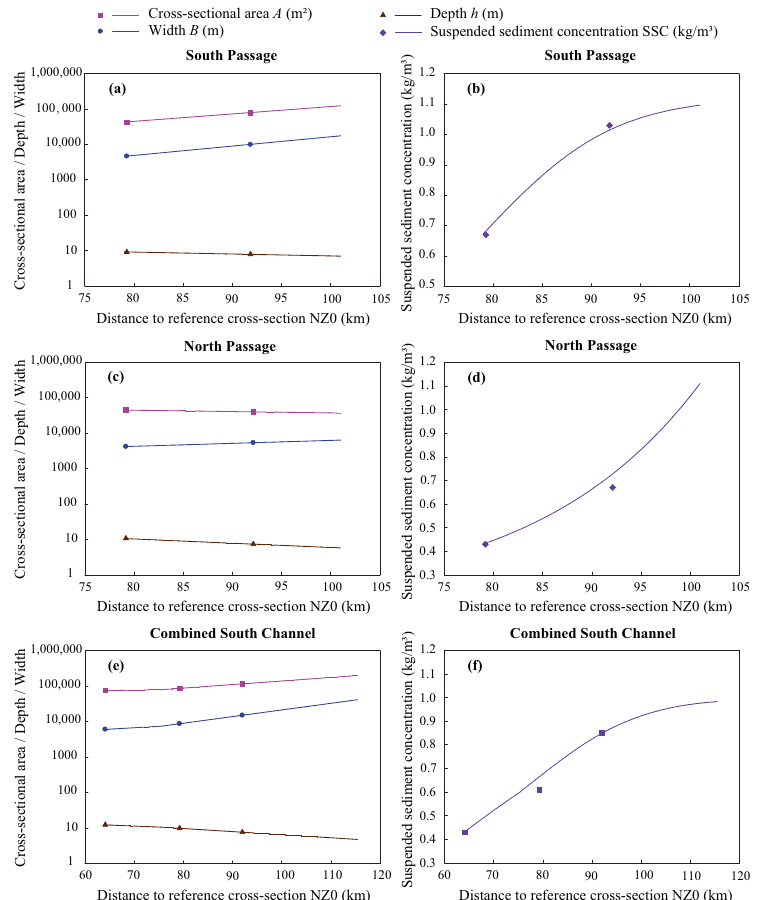
Figure 2. The computed topography and SSC distribution for the South Passage ( a , b ), North Passage ( c , d ), and the combined South Channel ( e , f ) on 13–14 February 2006, compared to observations. (Scatters represent observations, and the drawn lines represent the simulated